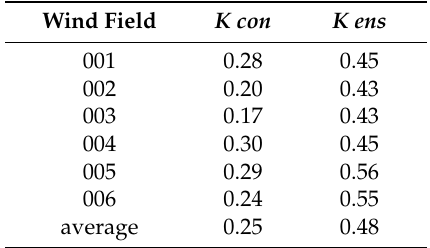
Table 1. Cluster index K of control predictions ( K con ) and ensemble forecasts ( K ens